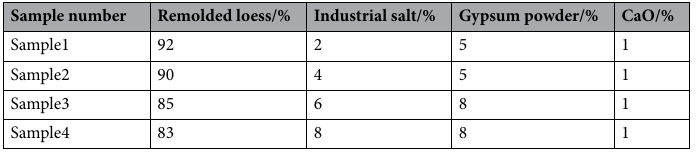
Table 2. Material proportion of artificially prepared samples.